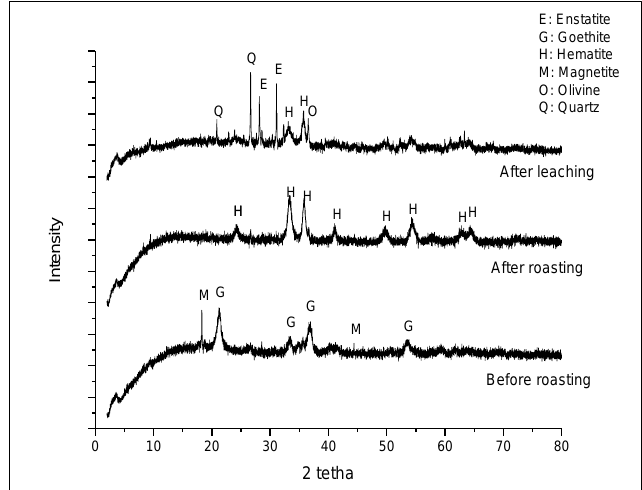
Figure 2. X-ray di ff raction analysis of raw limonite ore, roasted ore and residue after leaching. Figure 2 . X-ray diffraction analysis of raw limonite ore, roasted ore and residue after leaching.